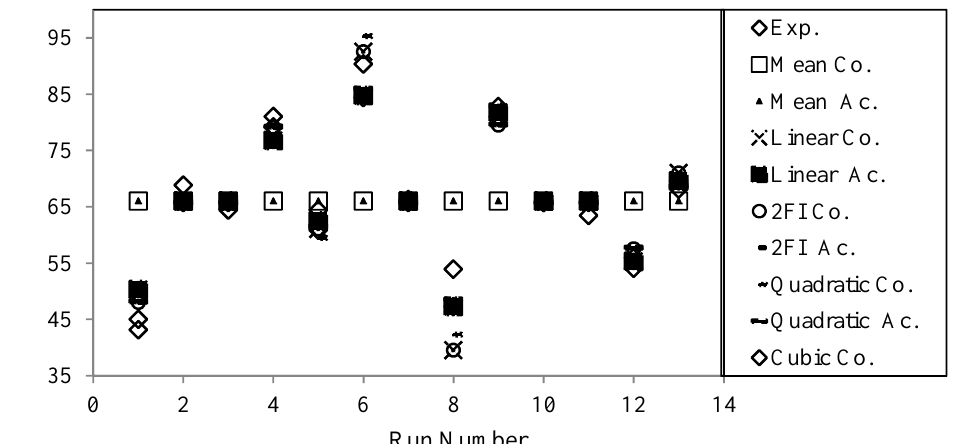
Figure 2. Ammonia removal efficiency pattern for applied